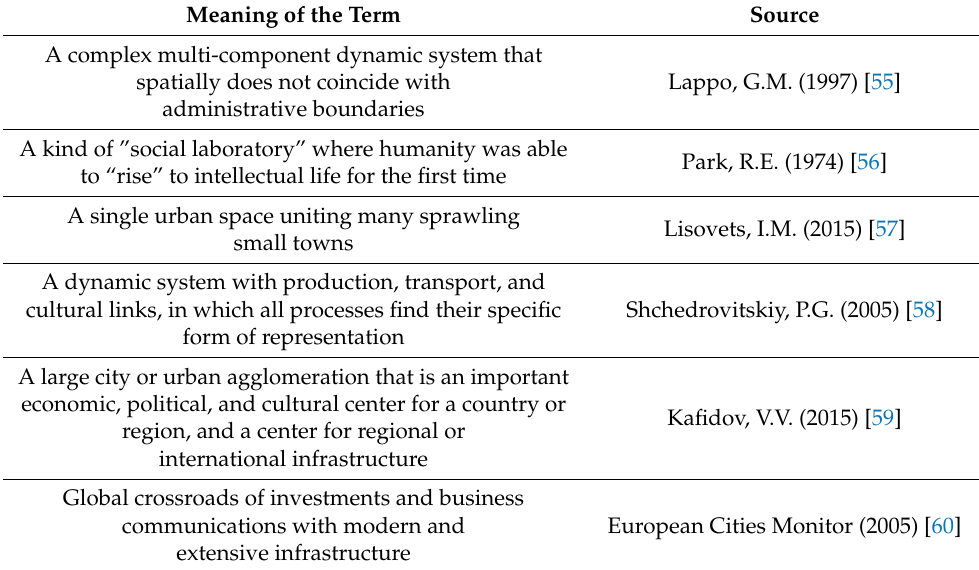
Table 1. Various approaches to the definition of a megapolis. Meaning of the Term